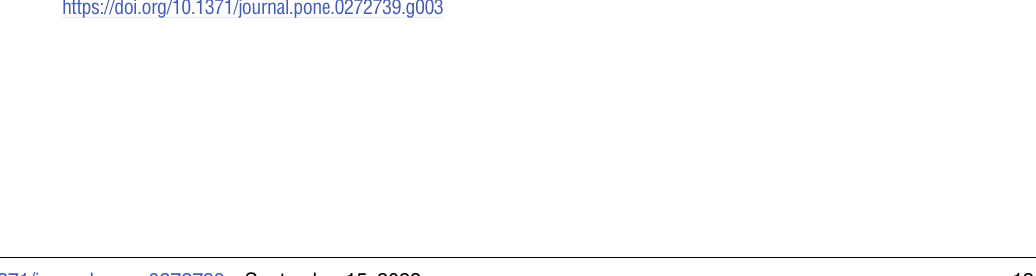
PLOS ONE | https://doi.org/10.1371/journal.pone.0272739 September 15,